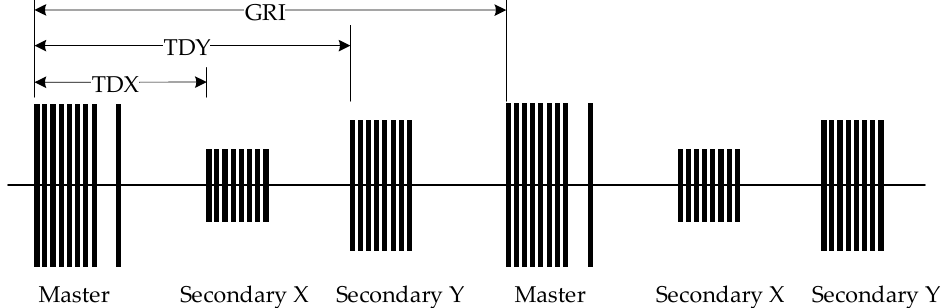
Figure 3. The signal transmission format of Loran-C navigation chains. Abbreviations: group repetition interval (GRI); time delay for first secondary station (TDX); time delay for second secondary station (TDY).